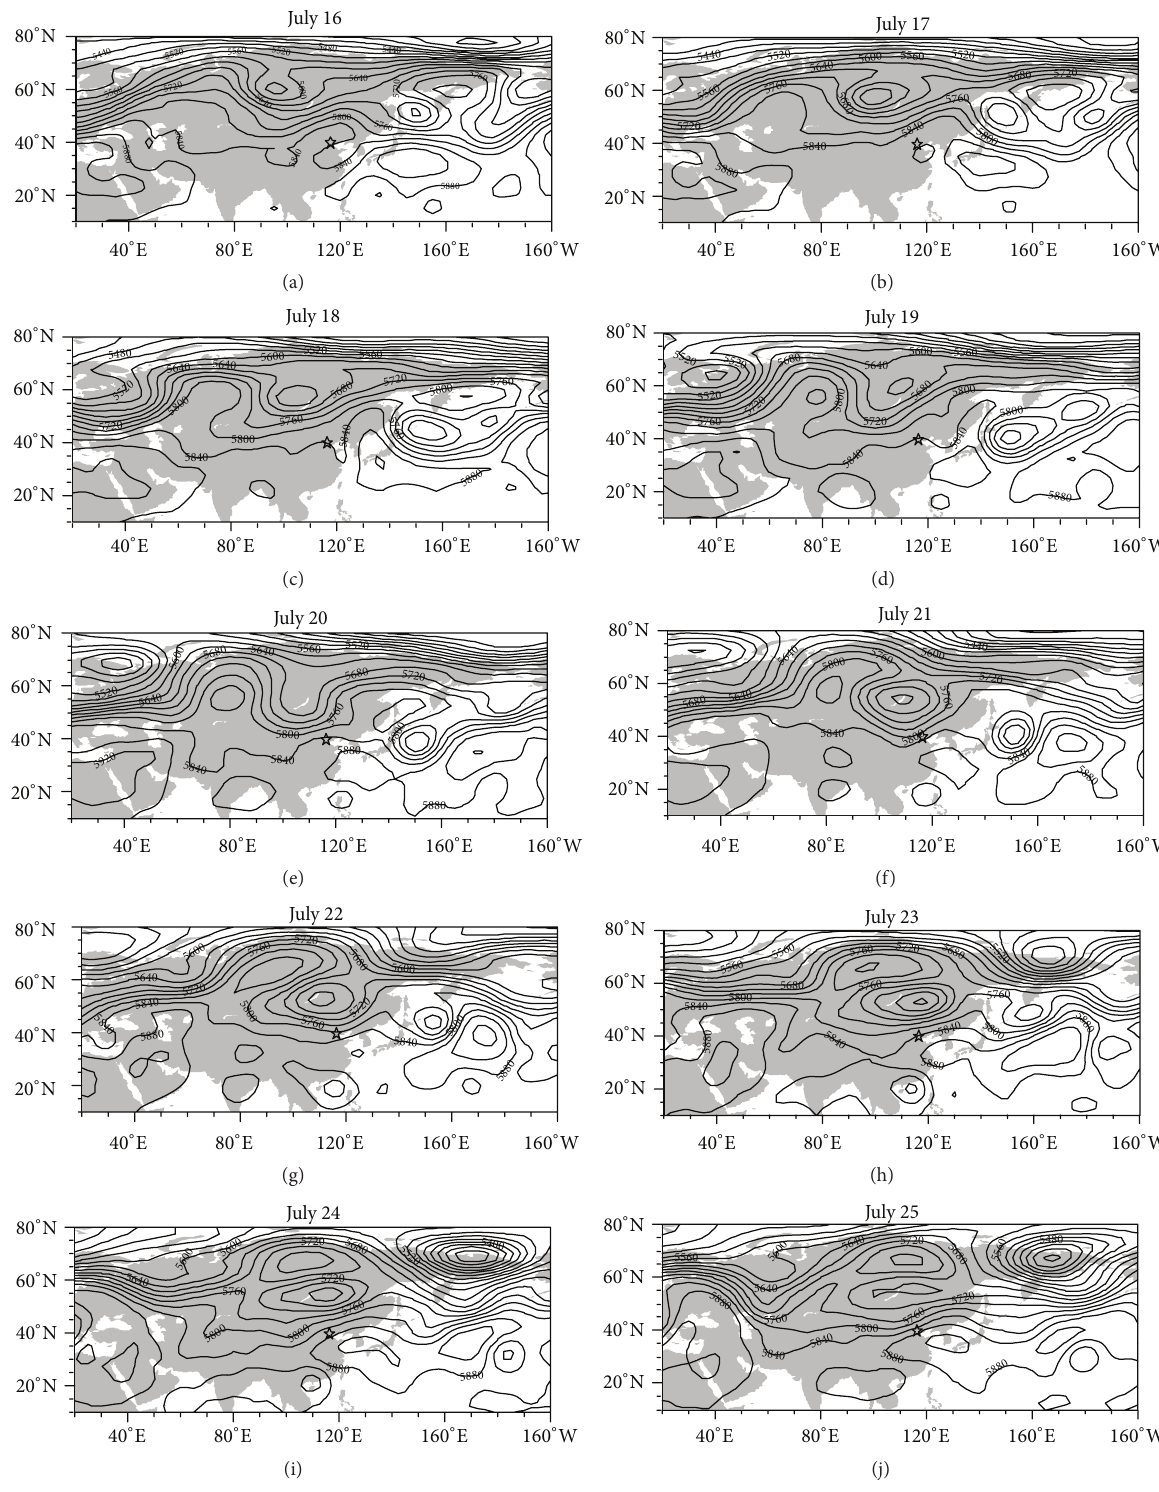
Figure 2: The daily 500 hPa geopotential height (contour interval: 40gpm) on July 16–25 (a–j), 2012. The pentagrams are on behalf of Beijing